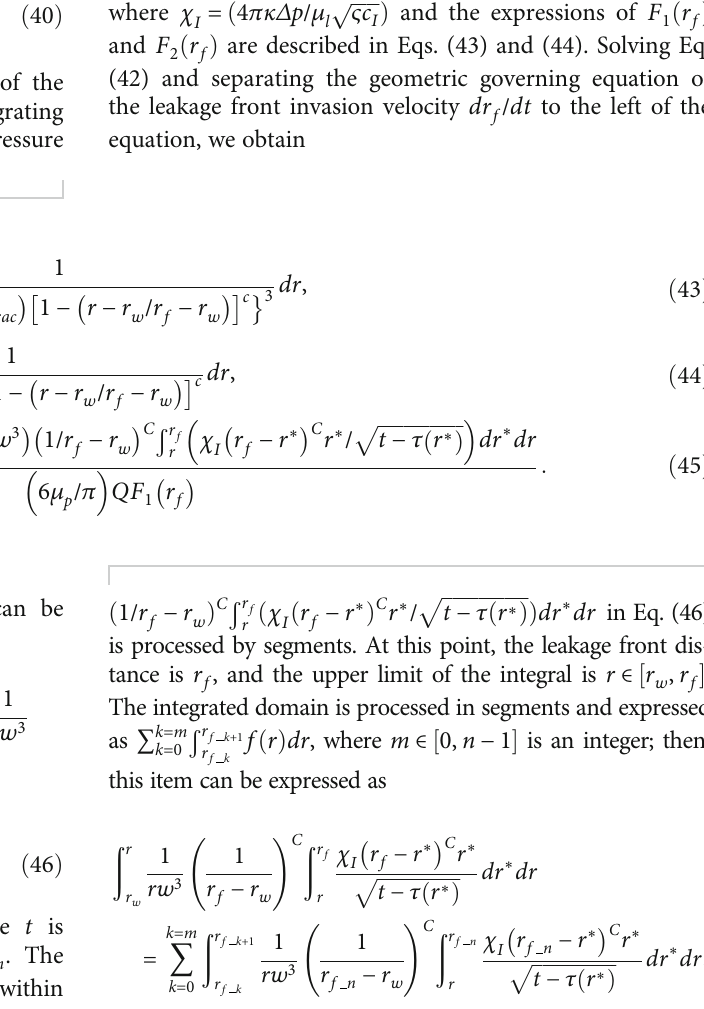
ffiffiffiffiffiffiffiffiffiffiffiffiffiffiffiffiffi p dr ∗ dr , t − τ r ∗ ð Þ ffiffiffiffiffiffi p ς c Þ and the expressions of F where χ Ι = ð 4 πκΔ p / μ l Ι and F 2 ð r f Þ are described in Eqs. (43) and (44). Solving Eq.